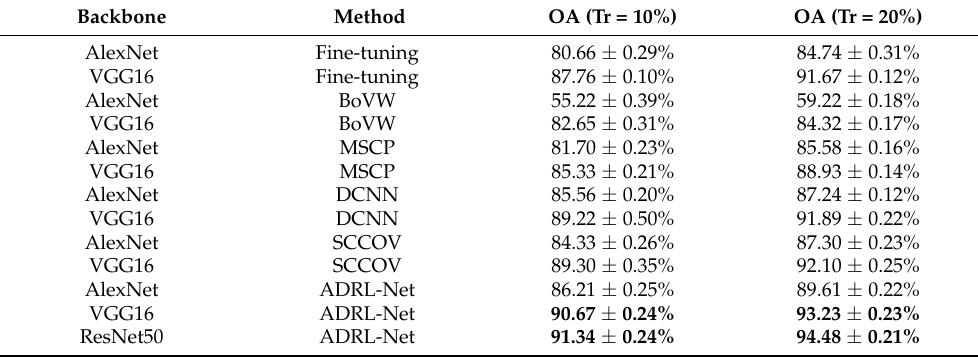
Table 3. OA comparison of different methods on NWPU dataset. The best two results are highlighted in bold font.